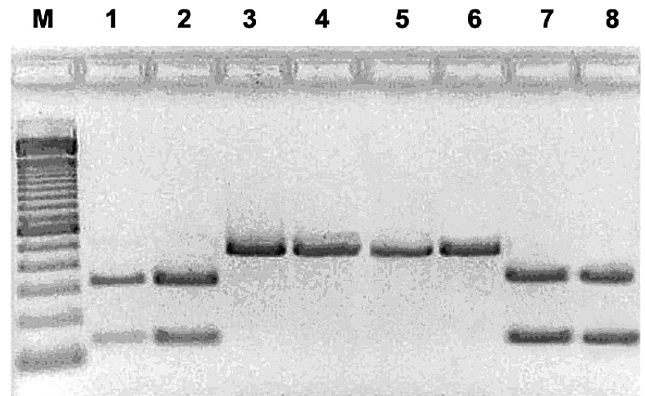
Figure 1. RT-PCR-RFLP pattern of leaf samples infected with different Tomato spotted wilt virus isolates, following amplification using primers 1F/1R and digestion with Xba I or Ava II. Lane M: 100 bp DNA ladder marker; lanes 1–4 were digested with Xba I and lanes 5–8 were digested with Ava II. Isolate GRAU digestion products are shown in lanes 1 and 5, isolate GA1L digests in lanes 2 and 6, isolate ZO digests in lanes 3 and 7, and isolate LL-N.05 digests in lanes 4 and 8.